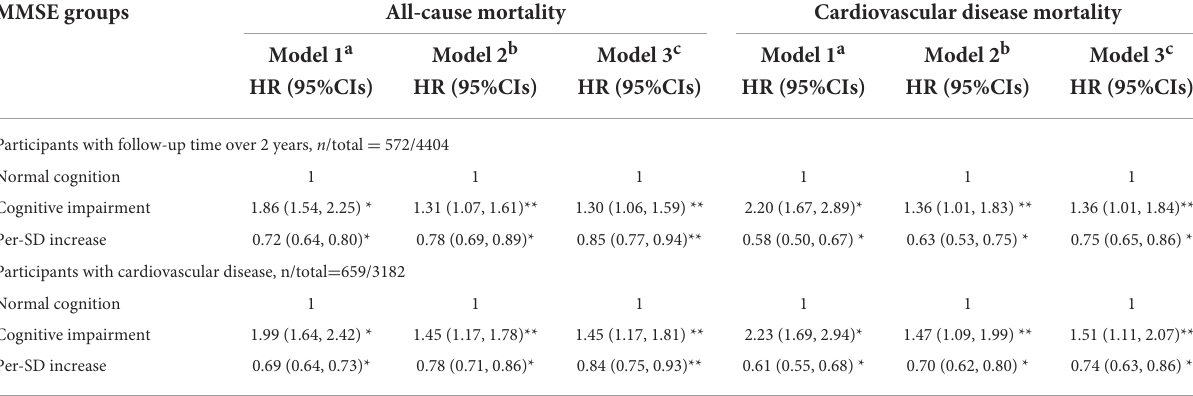
TABLE 4 Sensitivity analysis of the association between cognitive function and all-cause and CVD